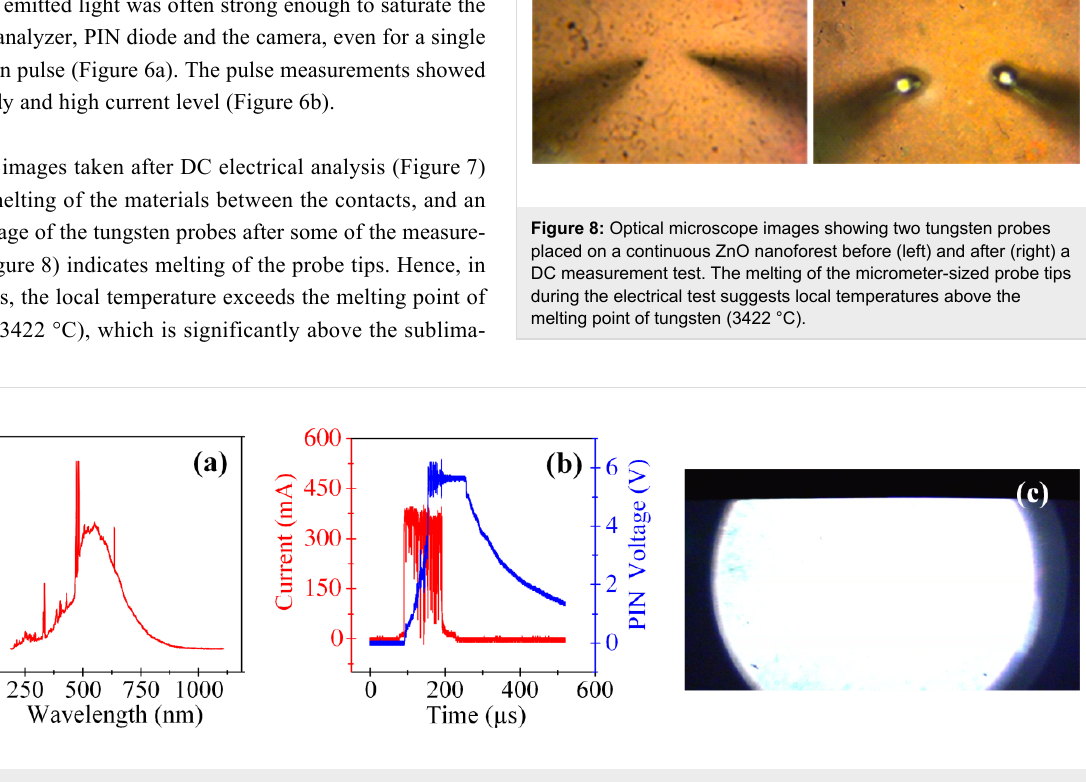
Figure 6: (a) Spectrum of the light emission resulting from application of a single pulse with amplitude of 45 V and duration of 100 μ s. The spectral line around 480 nm was clipped due to the saturation of the spectrum analyzer. The white light (broad spectrum) content was very strong for this pulse. (b) Current and PIN output voltage versus time measured by an oscilloscope. The photodiode used for this trial was very sensitive but not fast enough to capture the details, showing slow rise and fall times and saturation. The delay was primarily due to the response time of the built-in ampli- fier in the PIN diode package. The fluctuations in the current indicate the recurrent formation and termination of conductive paths between the contacts. (c) A frame extracted from the corresponding light emission video.